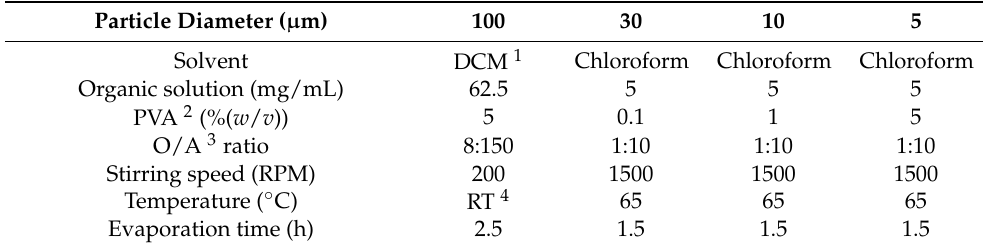
Table 1. Parameters for the fabrication of polymeric particles.